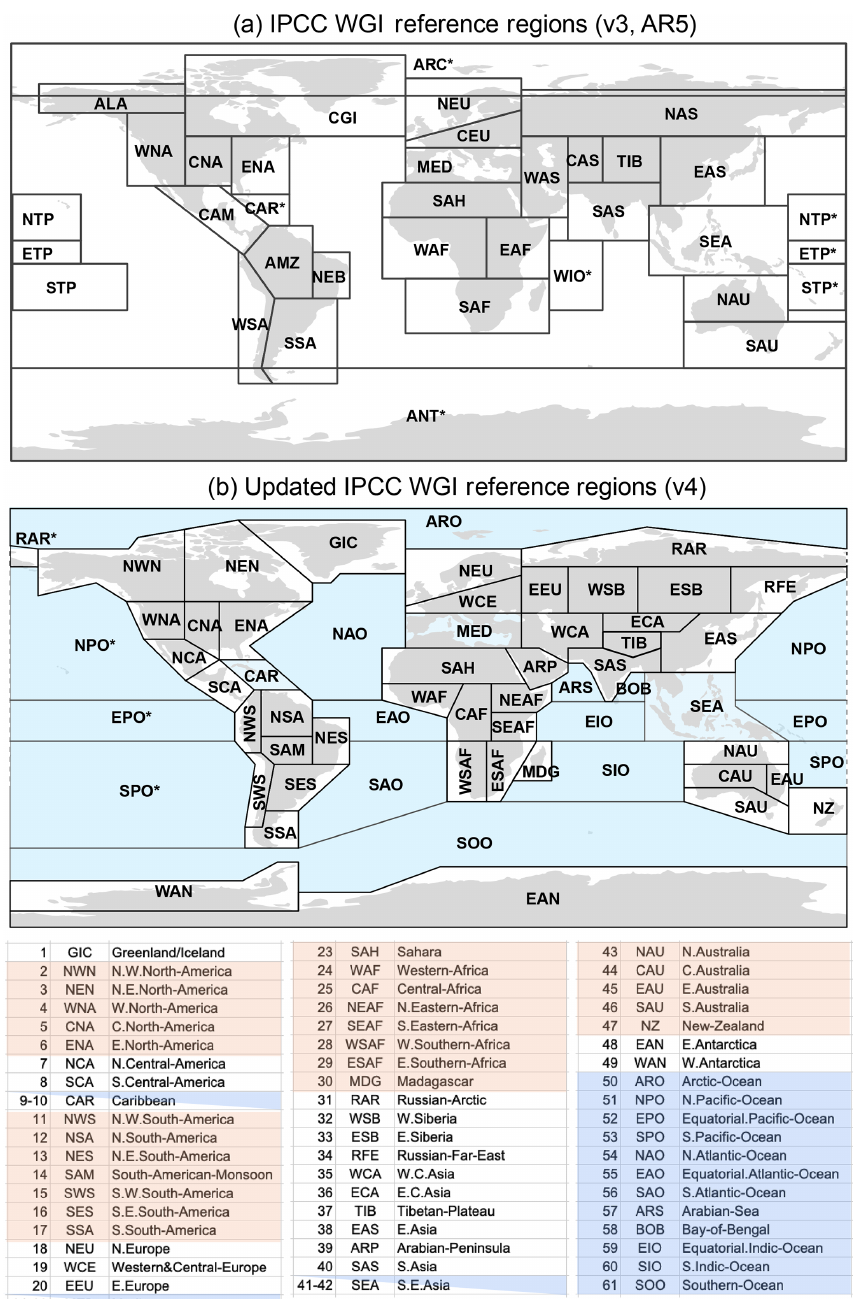
Figure 1. Updated IPCC reference land (grey shading) and ocean (blue shading) regions; note that the Caribbean, SEA and the Mediterranean are considered both land and ocean regions (defined using the land and sea masks, respectively). Land masks are used to obtain land-only information for land regions (excluding the coastal white